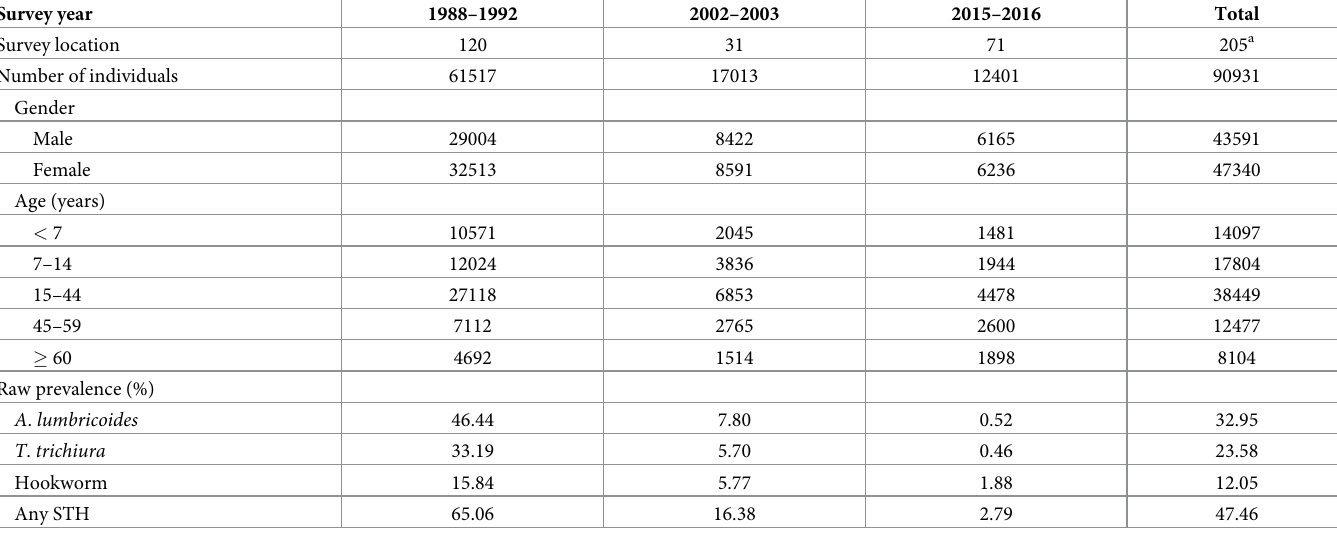
Table 2. Overview of characteristic of STH infection surveys data in Guangdong